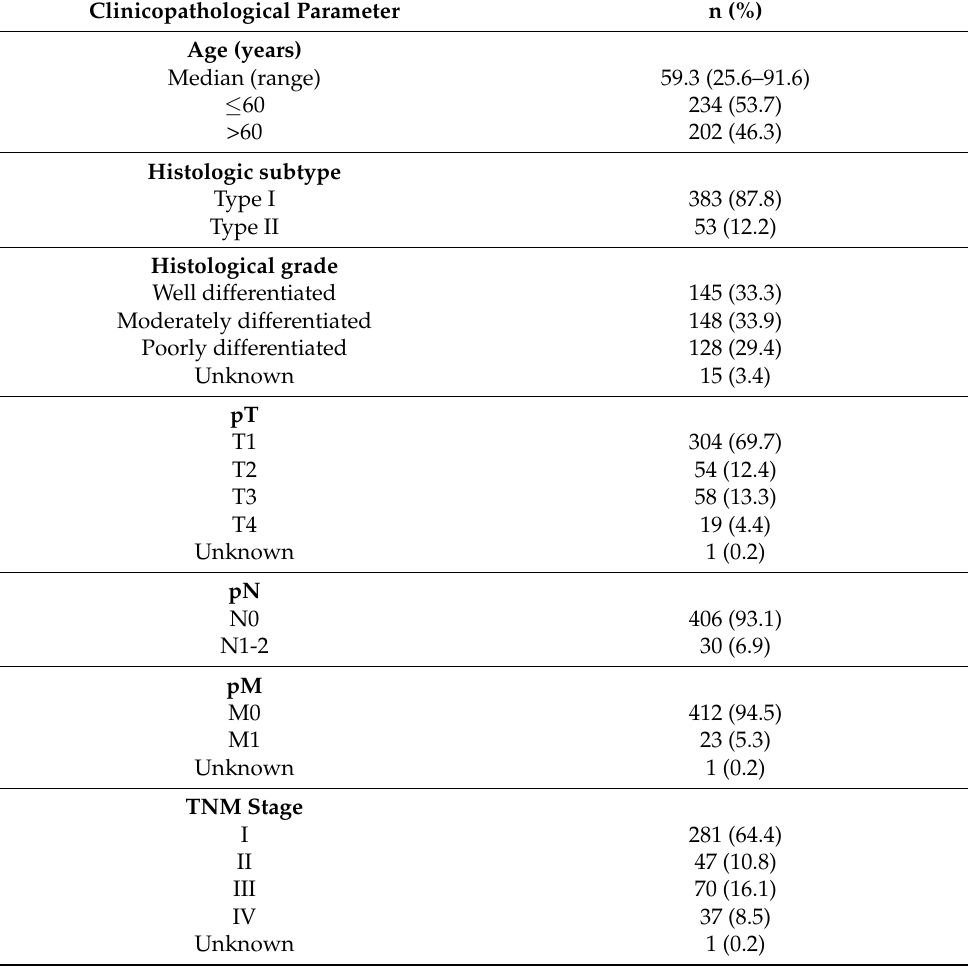
Table 1. Clinicopathological variables for the patient cohort (n = 436).